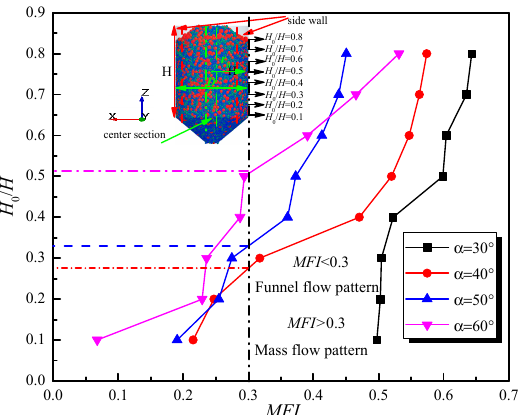
Figure 18. The variation in MFI with sinter layers for different half hopper angles. The velocity uniform index ( VUI ) is used to unfold the difference in velocity distribution at identical heights of the sinter layer. A lower value of VUI presents better stability of the velocity distribution in the sinter layer and is beneficial for the steady flow pattern. Figure 19 illustrates the variation in VUI as a function of the dimensionless height of the sinter layer with a varying half hopper angle. The value of VUI sharply increases with an increase in half hopper angle and a decrease in the dimensionless height of the sinter layer. The variation trend of velocity illustrates the significant fluctuation in the lower part of VSCB and the large value of the half hopper angle. The overall trend of the change in velocity in the vicinity of the sidewall declines, and the corresponding value for the central section steeply accelerates with an increase in the half hopper angle, leading to a substantial fluctuation in the magnitude of VUI with a varying half hopper angle.